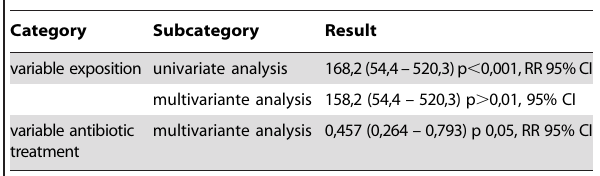
Table 6. Resistance phenotypes of MRSA CC398 originating from pigs and from humans at 47 farms investigated